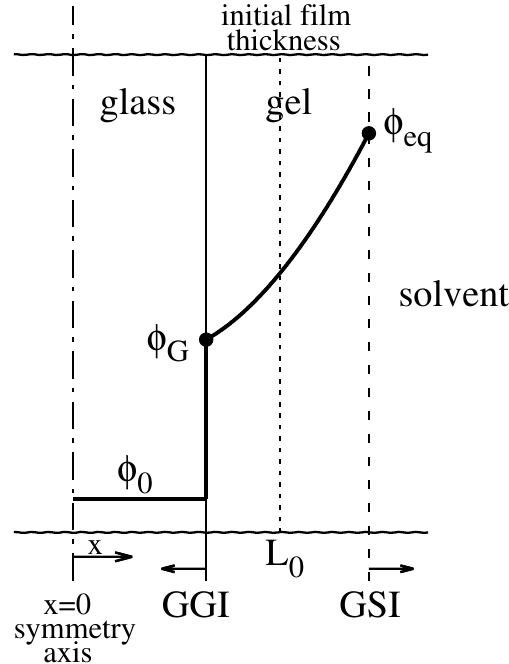
Figure 1. Schematic representation of solvent penetration in a glassy film (1-d Case II diffusion in the x direction). φ 0 , φ G , and φ eq are the solvent volume fractions in the glassy film, at the Glassy–Gel interface (GGI), and at the Gel–Solvent interface (GSI),